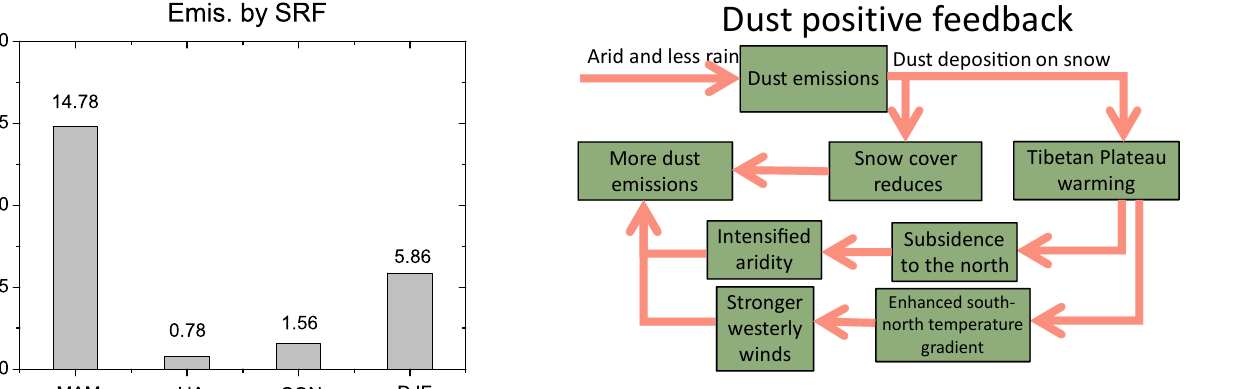
Figure 13. A schematic depiction of the feedback mechanism be- tween dust emission and dust-in-snow radiative